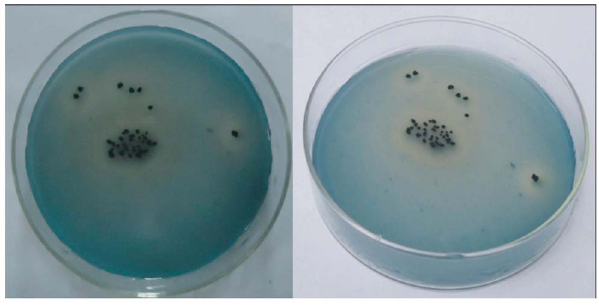
Figure 1. Degradation circles produced by Saccharomonospora viridis on azure B screening